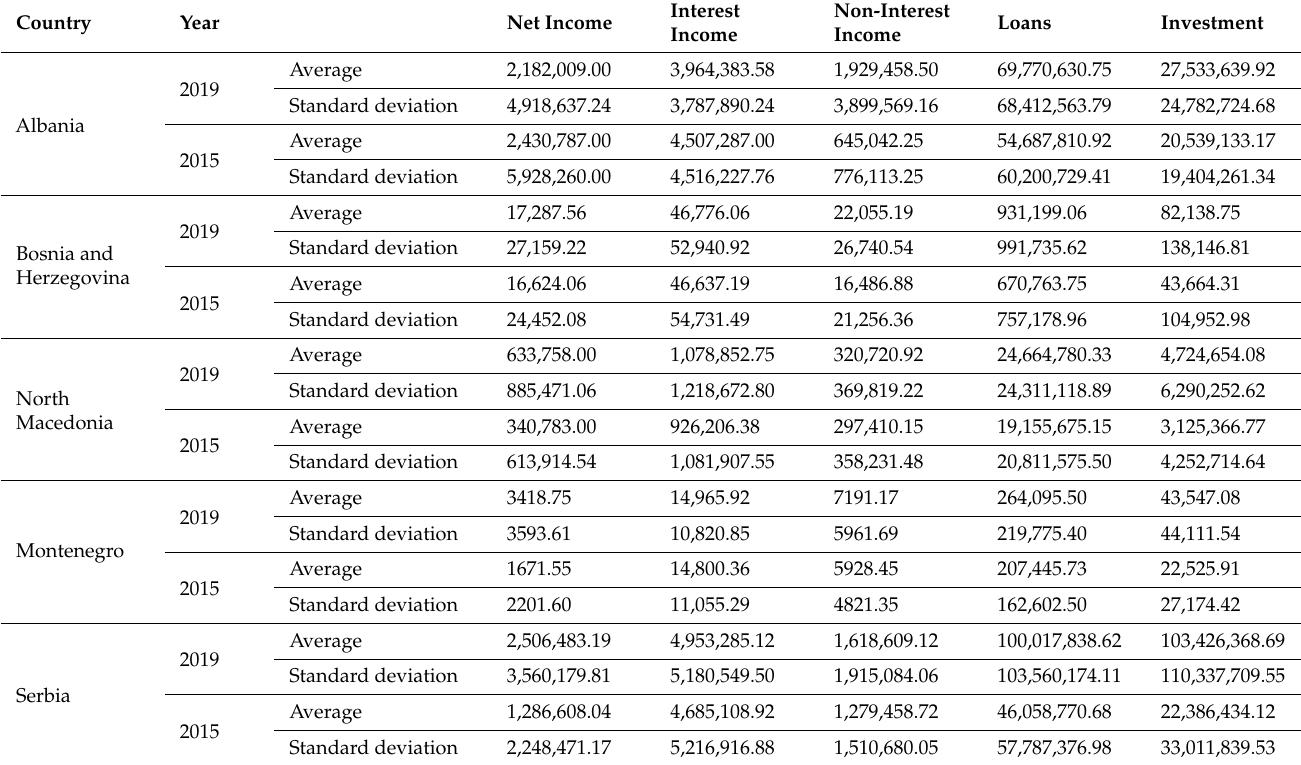
Table 1. Descriptive statistics of input and output